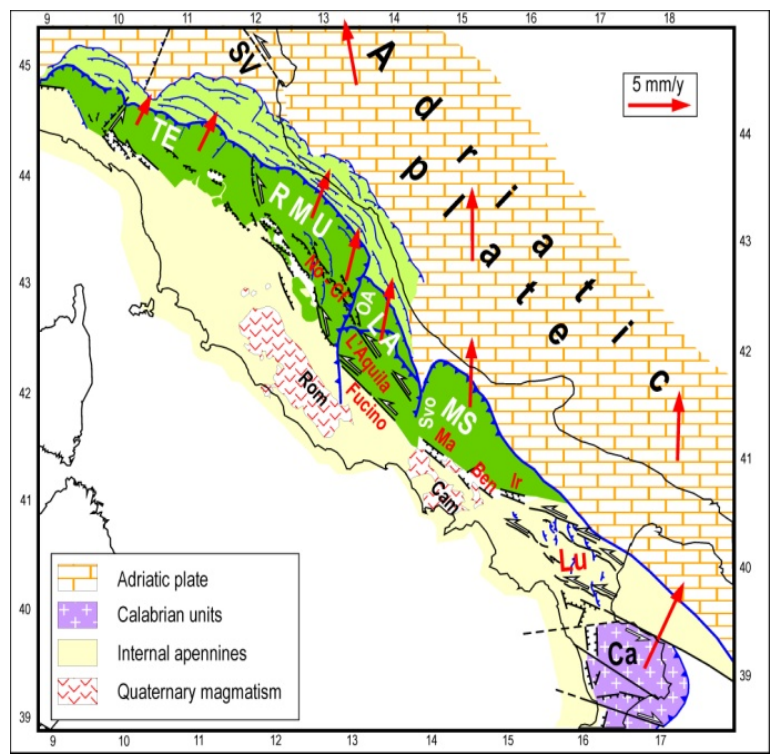
Figure 12. Dragged by the Adriatic plate, the eastern part of the Apennine belt (green) has undergone belt parallel shortening, which has caused the formation of oroclinal arcs and significant uplift. Ben = Benevento, Ca = Calabria, Cam, Rom = Campanian and Roman magmatic provinces, Ir = Irpinia, LA = Lazio-Abruzzi wedge, Lu = Lucania Apennines, Ma = Matese, MS = Molise–Sannio wedge, No-Cf = Norcia–Colfiorito fault system, OA = Olevano–Antrodoco thrust front, RMU = Romagna–Marche–Umbria wedge, SV = Schio–Vicenza fault, SVo= Sangro–Volturno thrust front, TE = Toscana–Emilia wedge. The buried external folds in the Northern Apennines are light green. Red arrows indicate the kinematic pattern, compatible with the Pleistocene deformation pattern and geodetic data (Figure 10). Other symbols as in Figure 1.